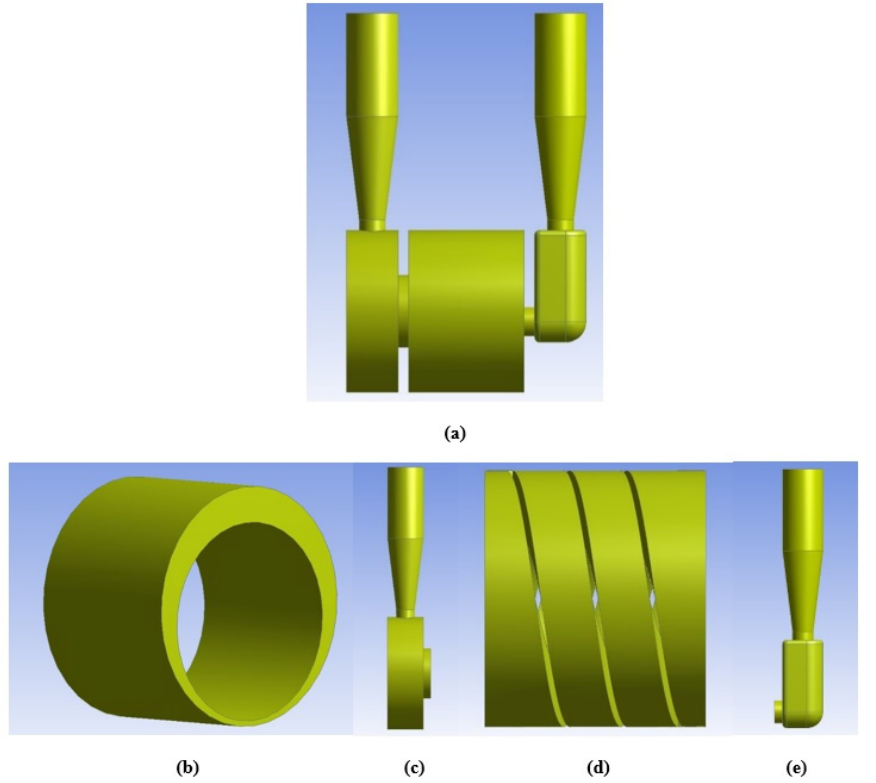
Figure 6. Computational model of ( a ) whole pump ( b ) casing ( c ) discharge chamber with water pipe ( d ) rotor volume and ( e ) suction chamber with water pipe.